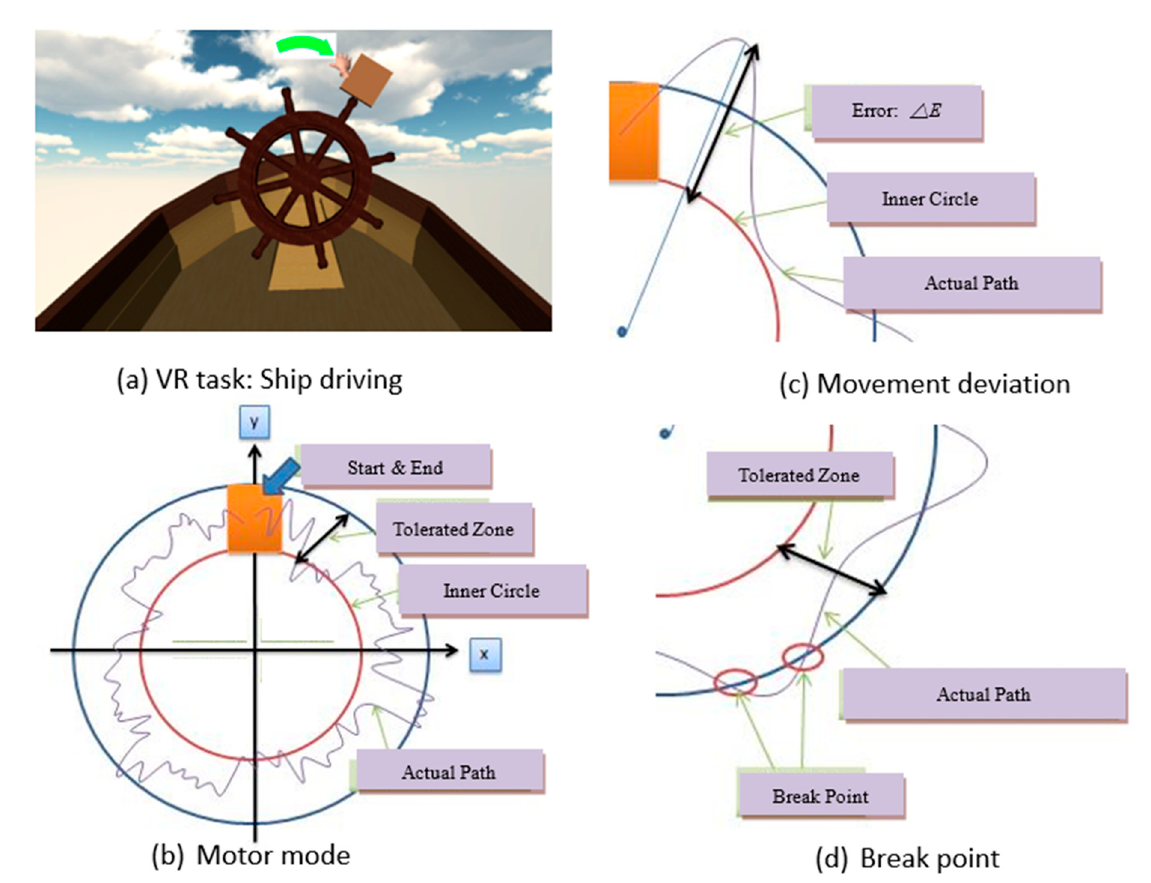
Figure 4. VR task: Ship Driving.